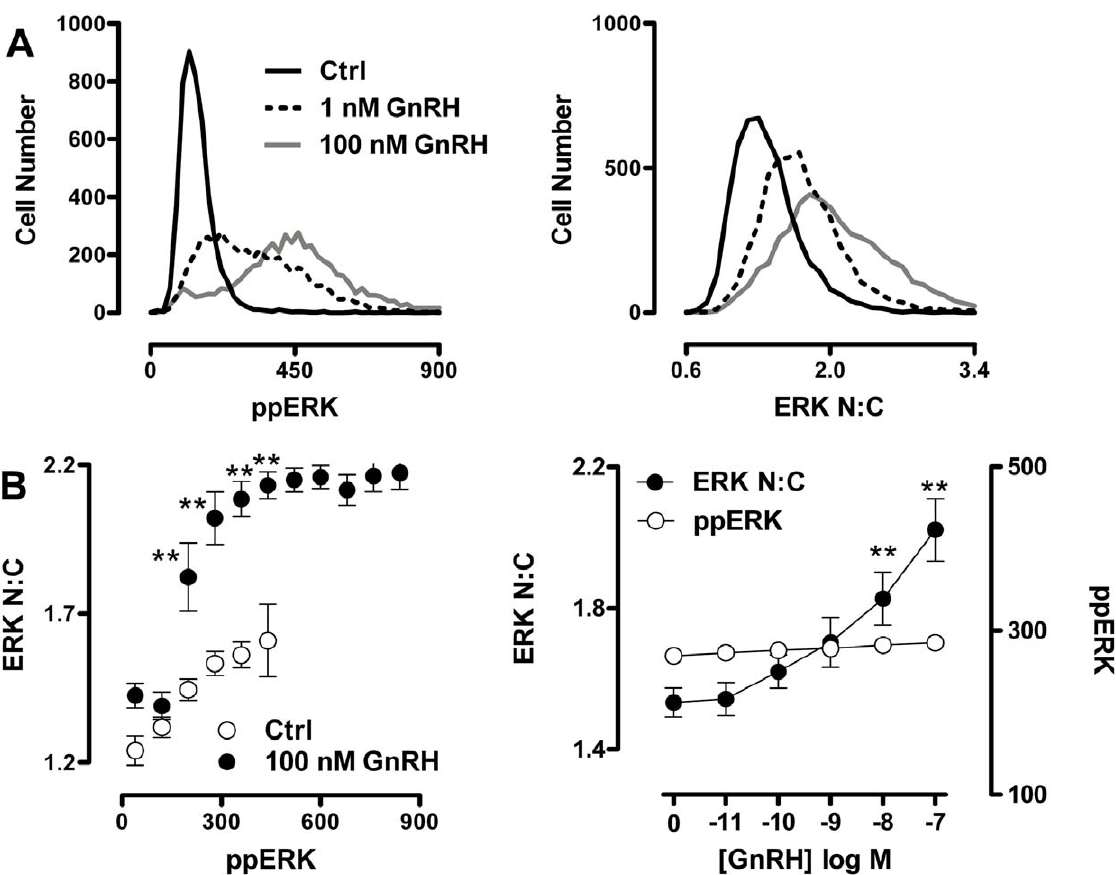
Figure 3. GnRH-mediated uncoupling of ERK phosphorylation from nuclear localization. Cells were treated, imaged and analysed as described for Fig. 2, except that the stimulation was for 5 min with varied concentrations of GnRH (as indicated). (A) Frequency histograms of individual cells (pooled from 2 independent experiments) were plotted according to ppERK stain intensity in AFU (left panel) and ERK N:C ratio (right panel) using the same cell population for both graphs. (B) The left panel shows direct comparison of ppERK levels to ERK N:C in Ctrl and 100 nM GnRH-stimulated samples. Individual cells were sorted into bins of ppERK staining intensity (80 AFU per bin, using a minimum bin size of 50 cells per experiment). The average ERK N:C ratio within each defined bin of ppERK staining intensity was calculated and is shown plotted against average ppERK stain intensity. Note that this plot effectively obscures the effect of the stimulus on ERK phosphorylation because the major effect of PDBu is to increase the number of cells in the higher ppERK bins (as shown in A). In doing so it reveals the TEY phosphorylation unattributable effect of PDBu: that is, the increase in ERK N:C under conditions matched for indistinguishable ppERK levels. The right hand panel illustrates the concentration- dependence of this effect with cells binned to ensure comparable levels of ppERK (240–320 AFU), plotting GnRH concentration against ERK N:C ratio (left y-axis)) and ppERK stain intensity (AFU, right y-axis). Data are shown from 13 separate experiments (mean 6 SEM). Two way ANOVA of data in the lower left panel revealed both ppERK bin and GnRH concentration as significant sources of variation (P , 0.01) and post-hoc Bonferroni tests revealed significant differences between control and GnRH-treated cells in the 200, 280, 360 and 440 AFU bins (**P , 0.01). Since this analysis does not permit unpaired data, only data from the first six ppERK bins were included. One way ANOVA of the ppERK data in the lower right panel revealed GnRH concentration as a significant source of variation (P , 0.01) and post-hoc Bonferroni tests revealed a significant difference between control and 10 or 100 nM GnRH-treated cells (**P ,